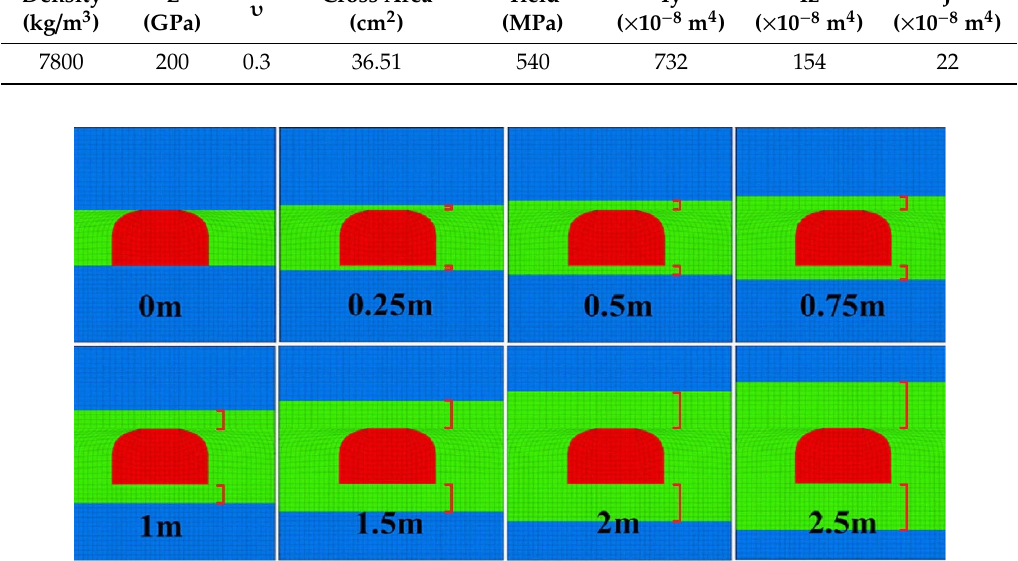
Figure 5. Study Case of Remaining Coal Thickness. Table 1. Mechanical properties of the rock.